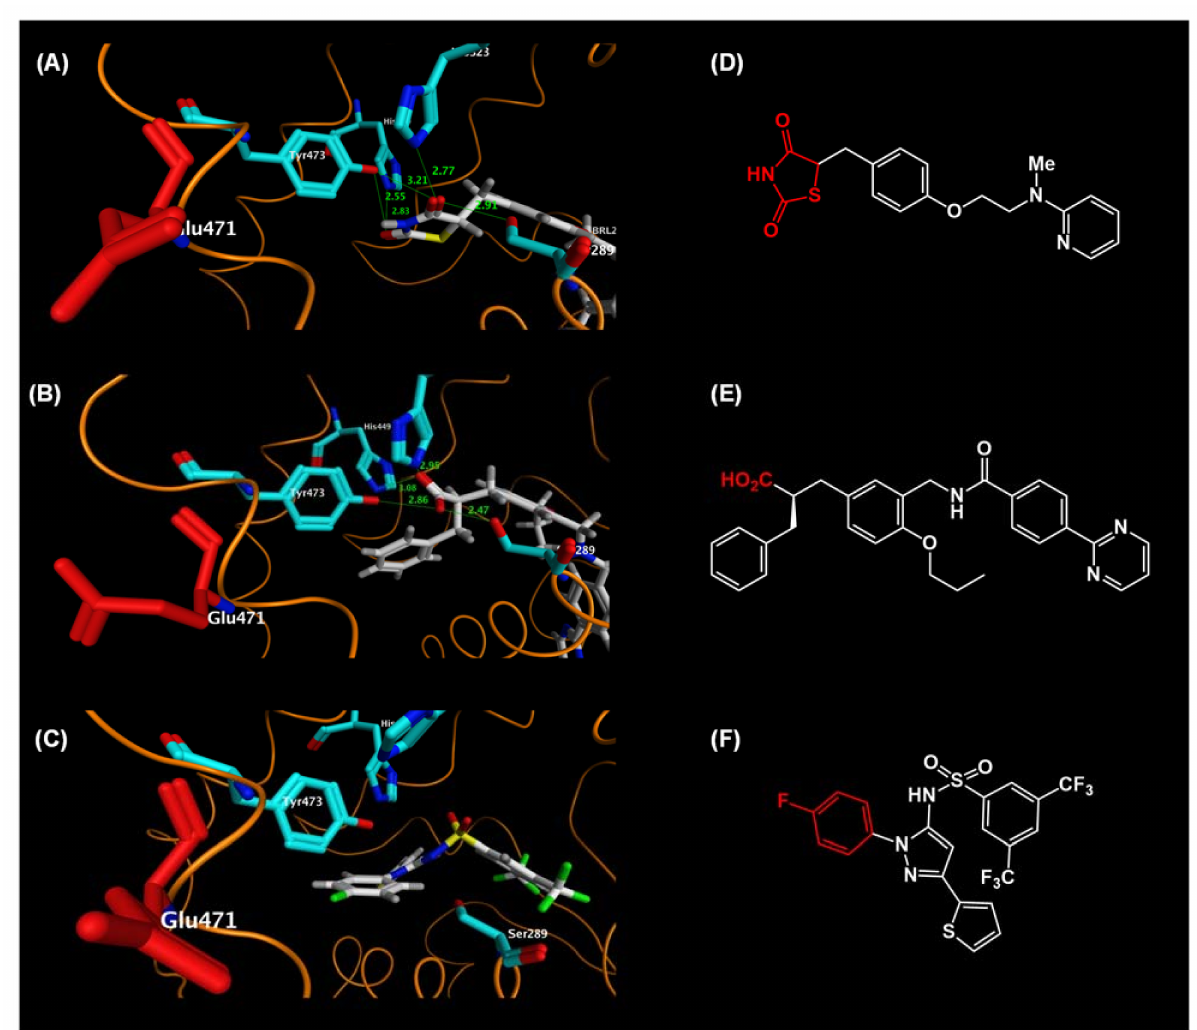
Figure 22. ( A – C ) Zoomed views of the binding mode of the AF2 region (H12 helix) of hPPAR γ LBD–rosiglitazone. ( A ) Zoomed view of the hPPAR γ LBD–rosiglitazone (full agonist) complex. ( B ) Zoomed view of the hPPAR γ LBD–MEKT-21 (partial agonist) complex. ( C ) Zoomed view of the hPPAR γ LBD– N -[1-(4-fluorophenyl)-3-(2-thenyl)- 1H-pyrazole-5-yl]-3,5-bis(trifluoromethyl)benzenesulfonamide (partial agonist) complex. ( D – F ) Chemical structures of these agonists. ( D ) rosiglitazone, ( E ) MEKT-21, and ( F ) N -[1-(4-fluorophenyl)-3-(2-thenyl)-1H-pyrazole-5-yl]-3,5-